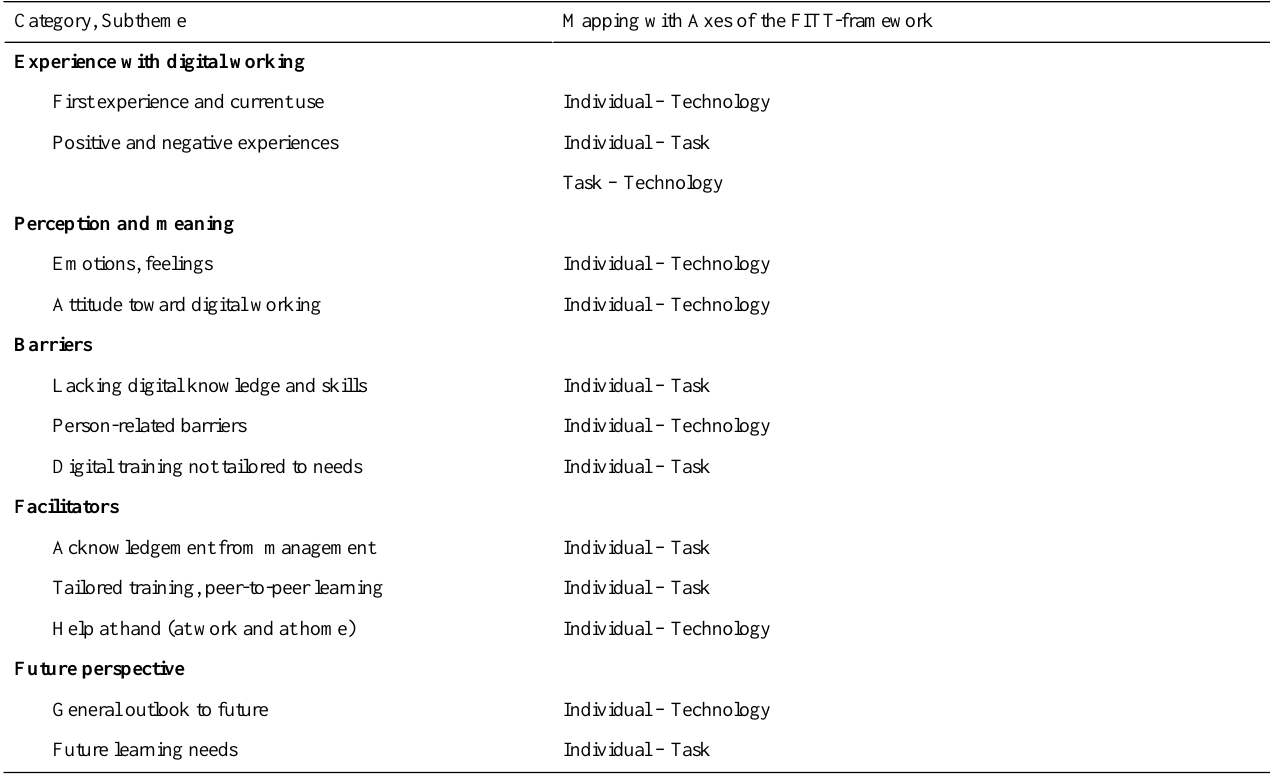
Table 2. Main categories, subthemes, and mapping with elements of the FITT- framework; FITT: fit between Individiaul, Task, and Technology.